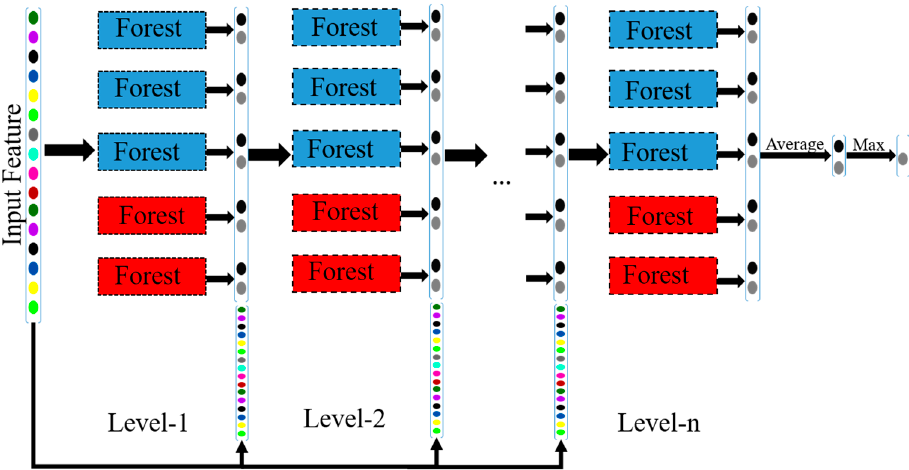
Figure 5. Illustration of the structure of a Cascade Forest Model (CFM).